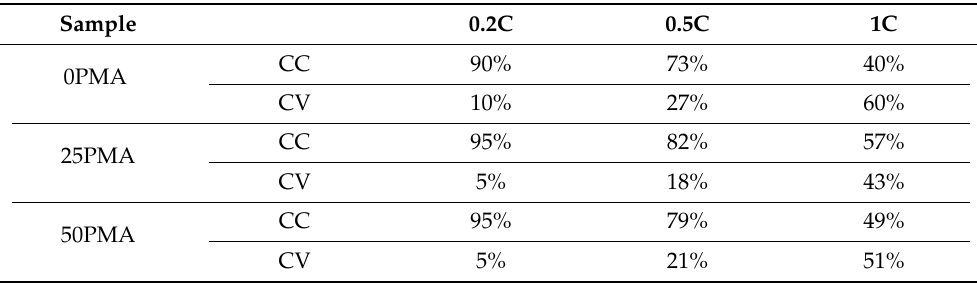
Table 4. Average values of galvanostatic (CC) and potentiostatic (CV) contributions to the specific charge capacity for different